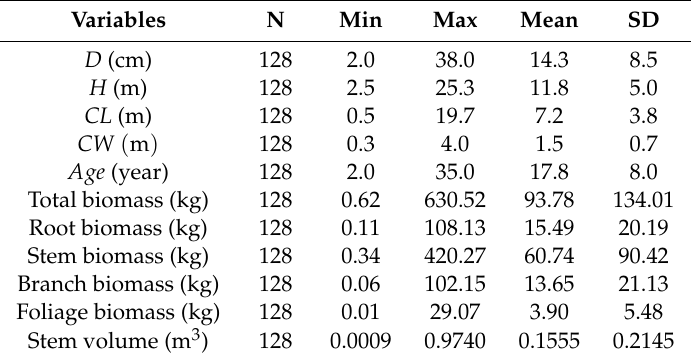
Table 1. Summary statistics of tree variables, tree biomass, stem volume and biomass conversion and expansion factors for the sampled Populus × xiaohei